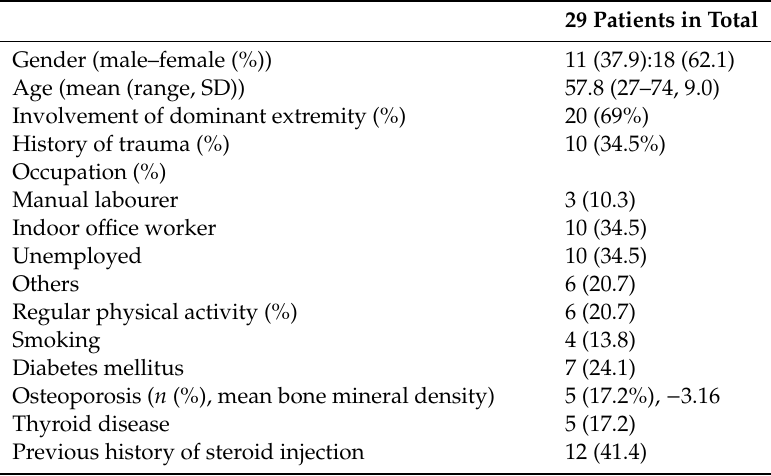
Table 1. Patients’ demographics.